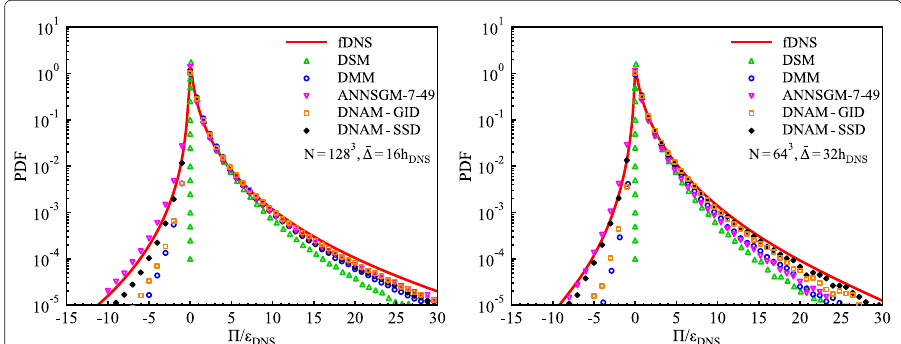
Fig. 7 PDFs of the normalized SGS energy flux DNS in aposteriori